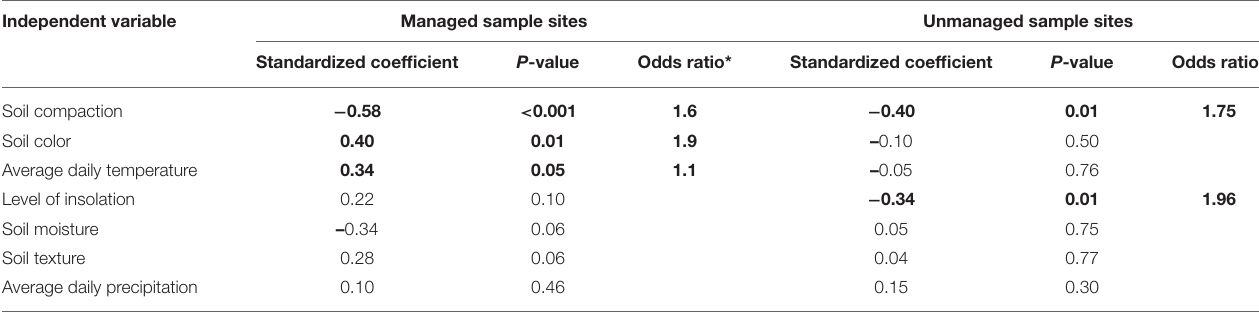
TABLE 1 | Comparison of all variables in each of the logistic regression models, showing standardized coefficients ( z score: z = (x– µ )/ σ ) for predicting high infiltration rate ( ≥ 1.75 mL/min) and their significance level. Independent variable